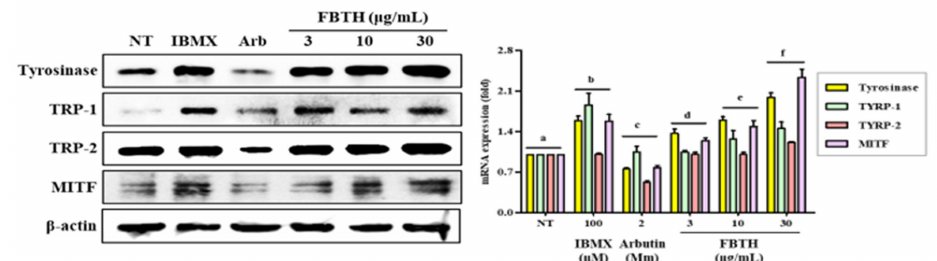
Figure 4. Effects of the FBTH on the expression of melanogenesis-related proteins in Melan-A cells. Cells (1 × 105 cells/mL) were cultured with FBTH for 72 h, and the protein levels were analyzed by Western blotting, and the statistical analysis of protein band density was shown. IBMX (100 µ M) was used as the positive control, and arbutin (2 mM) was used as the negative control. NT: No treatment. Data are expressed as the mean ± SD ( n = 3). All tests were performed in triplicate. Different letters stand for statistically significant each other ( p < 0.05) performed by one-way ANOVA followed by Tukey’s test.